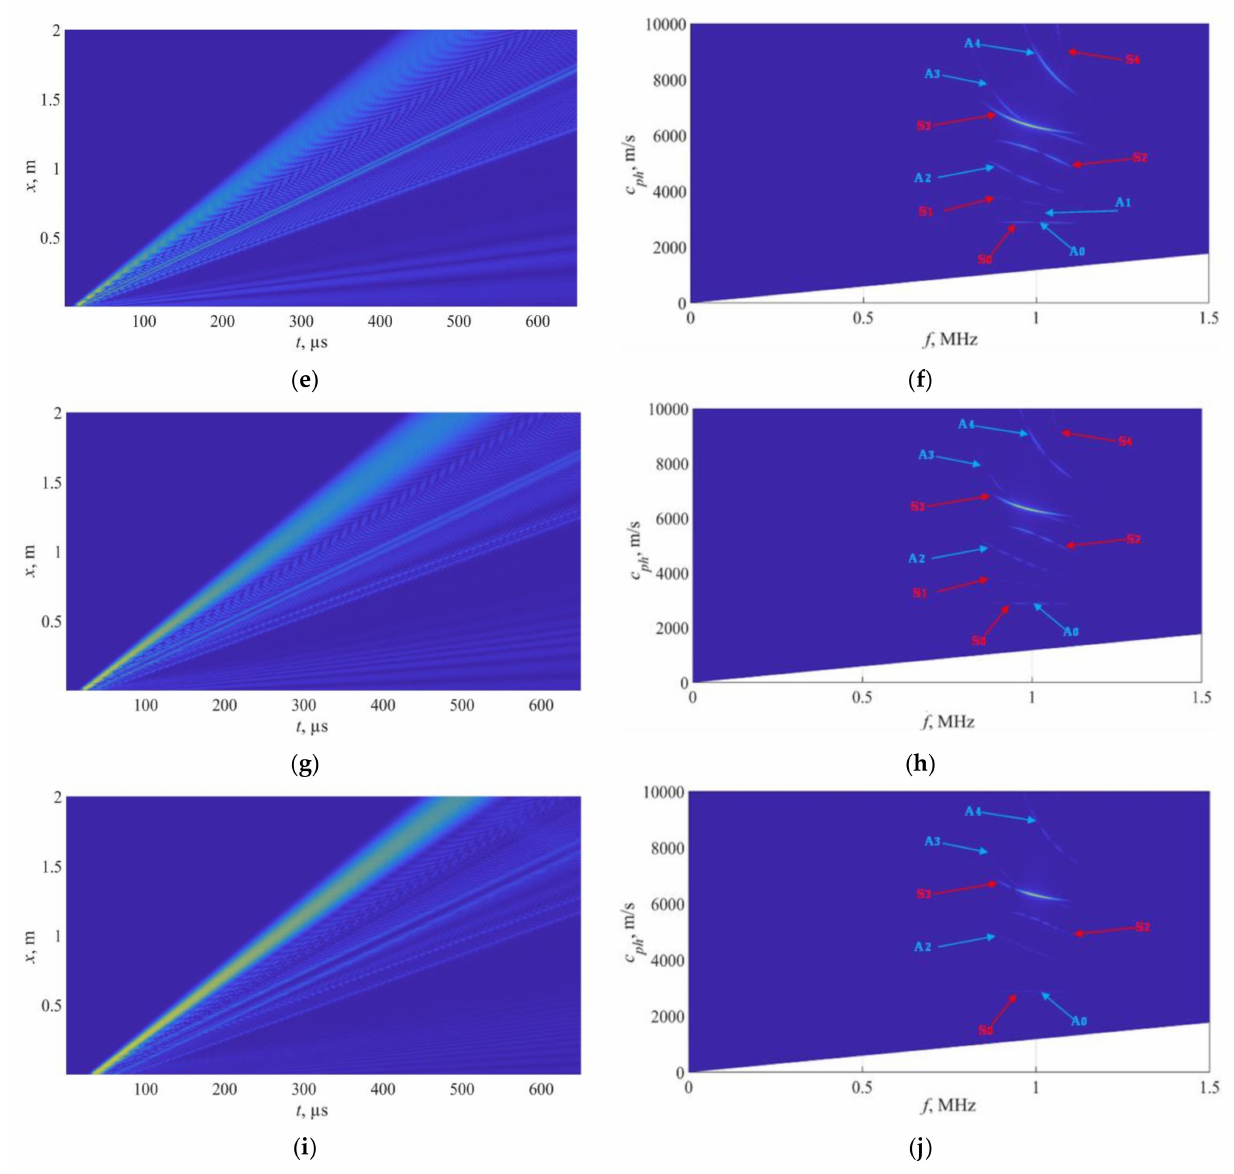
Figure 9. B-scans and reconstructed phase velocities in case of different length excitation zone: ( a , b )